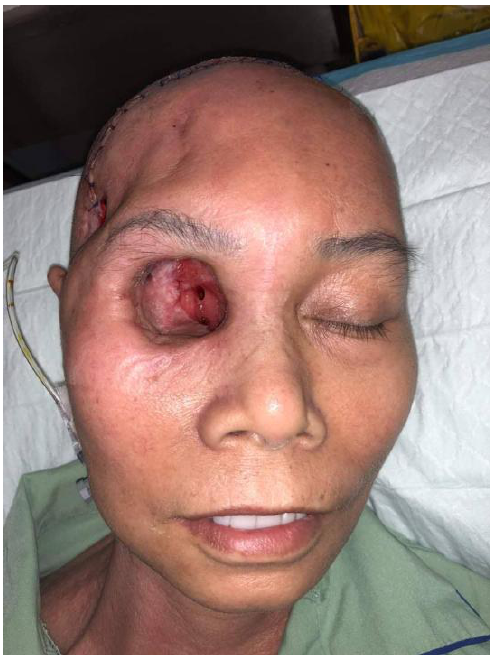
Figure 1: Intraorbital wall defect post exenteration of the right orbit exposing the right optic canal surrounded by granulation